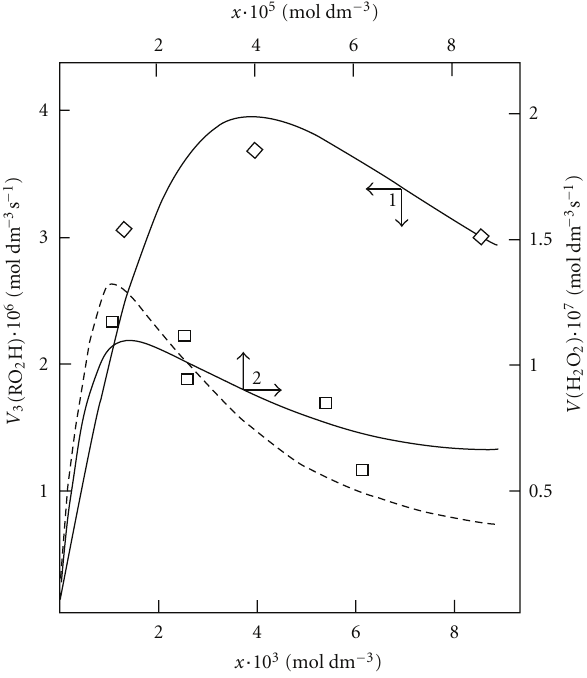
Figure 3: (1) Reconstruction of the functional dependence of the 2- methylbenzyl hydroperoxide formation rate V 3 (RO 2 H) on the ini- tial dissolved oxygen concentration x from empirical data (points) using (3b) (model optimization with respect to the parameter α ) for the o-xylene-oxygen system at 373 K [45] (standard deviation of S Y = 5 . 37 × 10 − 7 . (2) Reconstruction of the functional dependence of the total hydrogen peroxide formation rate V 3, 7 (H 2 O 2 ) on the initial dissolved oxygen concentration x from empirical data (symbols) using (3b) and (12) with β = 0 (model optimization with respect to the parameter α ) for the γ -radiolysis of water saturated with hydrogen and containing di ff erent amounts of oxygen at 296 K [54] ( S Y = 1 . 13 × 10 − 8 ). The dashed curve described V 3 (RO 2 H) as a function of the initial oxygen concentration x based on (3b) model optimization with respect to α ) and the experimental data of curve 2 ( S Y = 1 . 73 × 10 − 8